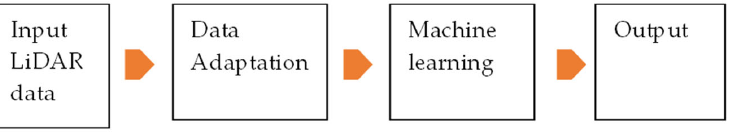
Figure 2. Structure of ML algorithm of LiDAR data processing.